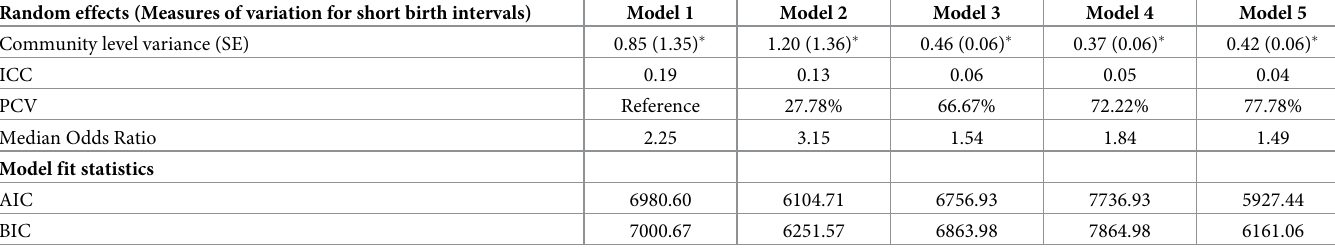
Table 3. Results from random intercept model (measures of variation) to assess the factors associated with short birth intervals at the individual-, household-, com- munity-, and health facility-level, BDHS 2017/18. Random effects (Measures of variation for short birth